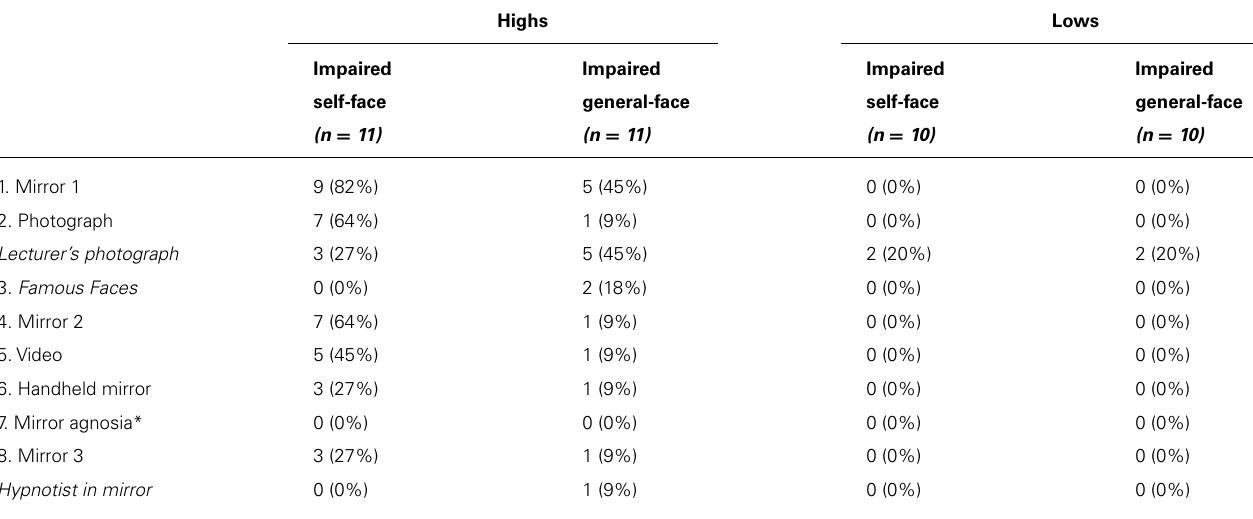
Table 1 |The number and percentage of participants who failed the visual